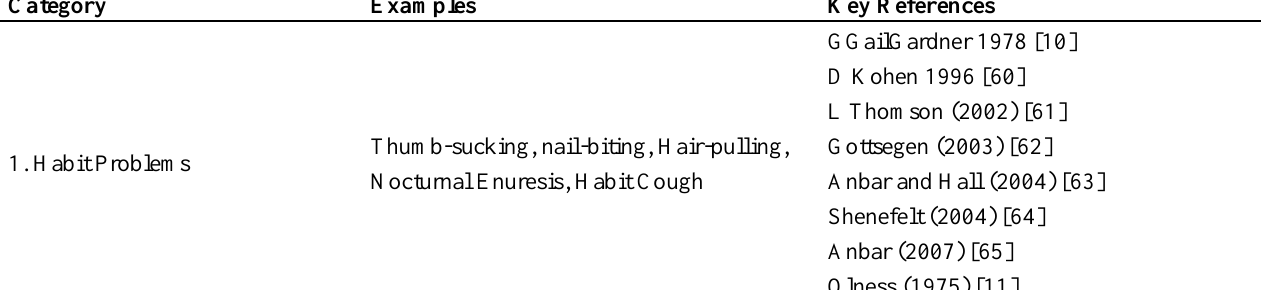
Table 2. Applications of Hypnotherapy for Children and Adolescents * . Category